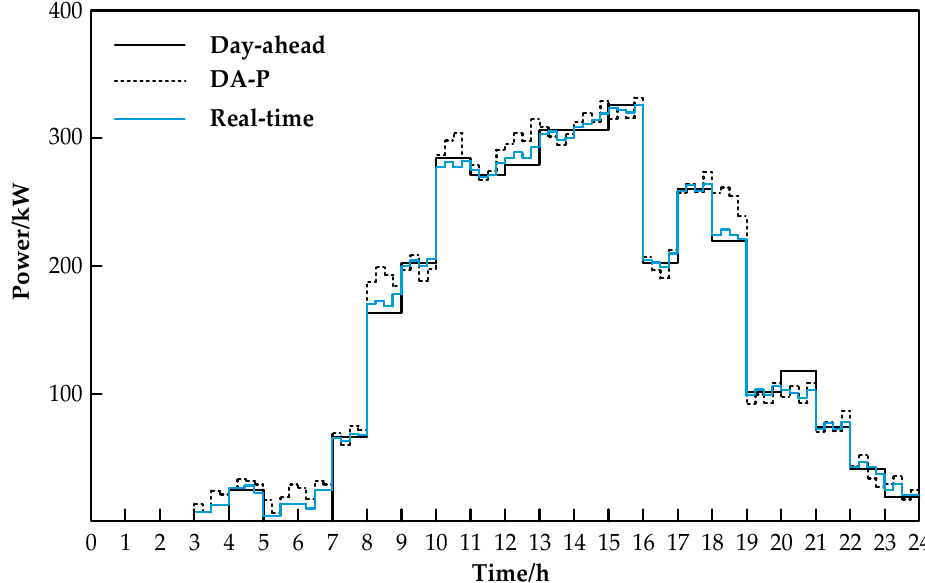
Figure 11. Comparison of day-ahead, DA-P policy scheduling and real-time contact line interactive power scheduling results.